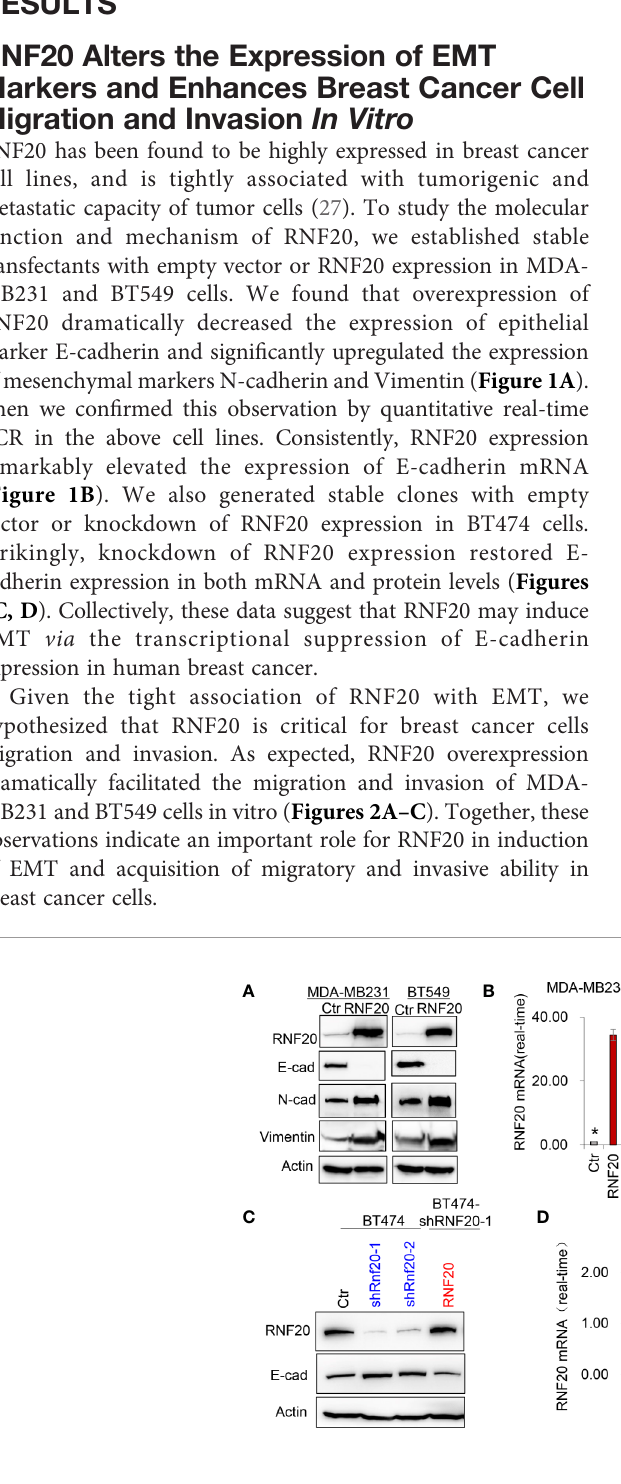
FIGURE 1 | RNF20 alters the expression of epithelial-mesenchymal transition (EMT) markers. (A) Expression of E-cadherin, Vimentin and RNF20 in the MDA-MB231 and BT549 cells was analyzed by Western blotting. Actin was served as a loading control. (B) Expression of RNF20 and E-cadherin was analyzed by qPCR in MDA- MB231 and BT549 cells infected with empty vector (Ctr) or RNF20-expressing vector. *P < 0.01 by Student ’ s t test. (C) Expression of E-cadherin, and RNF20 was analyzed by Western blotting in BT474 cells with stable empty vector or knockdown of RNF20 expression as well as shRNF20-expressing BT474 cells infected with plvx-neo-RNF20. (D) Expression of RNF20 and E-cadherin was analyzed by qPCR in cells from (C) . *P < 0.01 by Student ’ s t